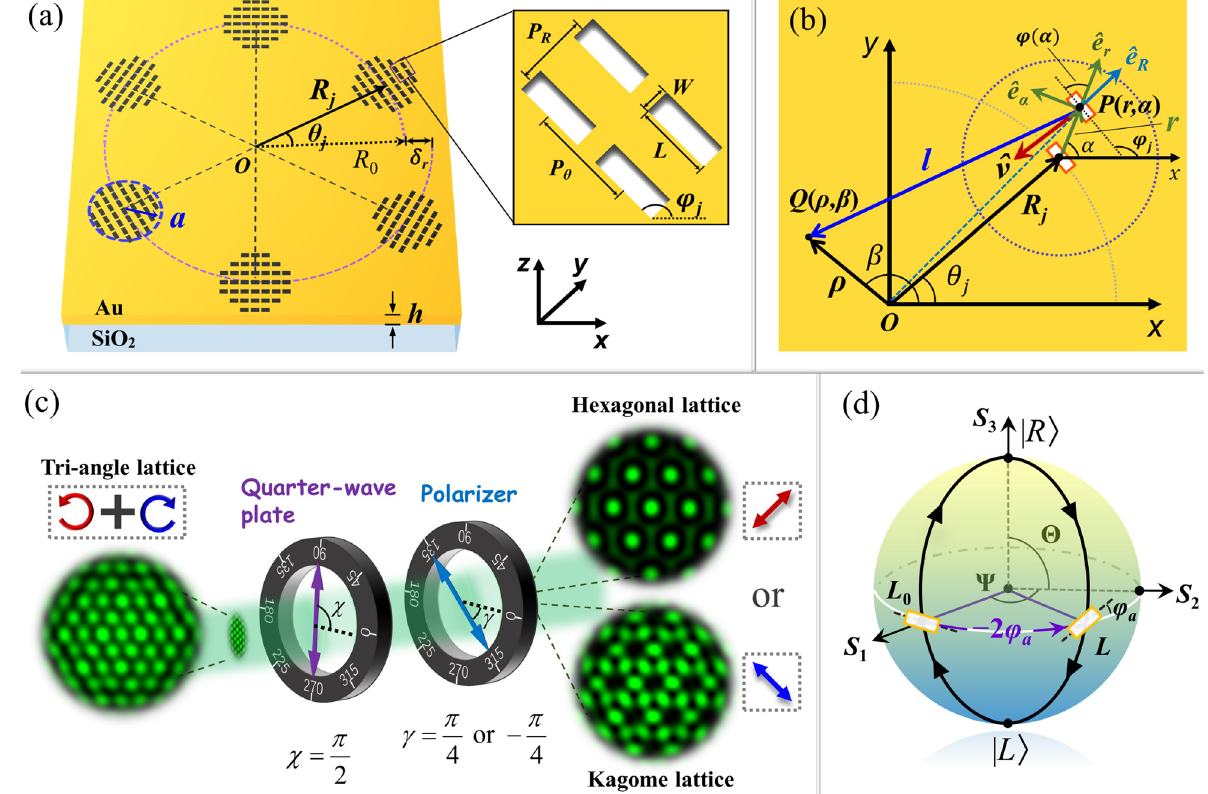
Figure 1: Demonstration of principle and method for metasuface designs (a) Schematic of the metasurface. The radius of each aperture is a =1.75 μ m,thespiralat whichtheaperturesarelocatedhasaprimaryradius R 0 =12 μ m,andthethicknessof thegold fi lmis h =200 nm.The nanoslits are arranged in a square lattice with lattice constant P R = P θ = λ spp . The length of the slit L = 250 nm and width W = 110 nm. (b) Illustrationoftheslitorientationandlocalpolarcoordinates.(c)Illustrationofthepolarization fi lteringprocessing. χ and γ denotethefastaxis and transmission axis directions of the QWP and polarizer, respectively. (d) Poincaré sphere for illustration of the conversion of the polarization state and geometric phase change of the converted spin